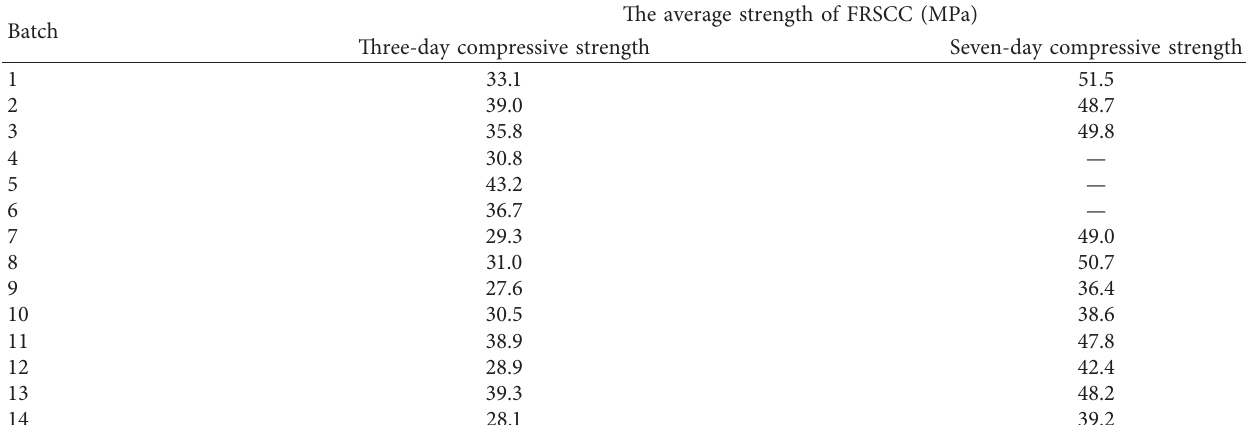
Table 4: Compressive strength test